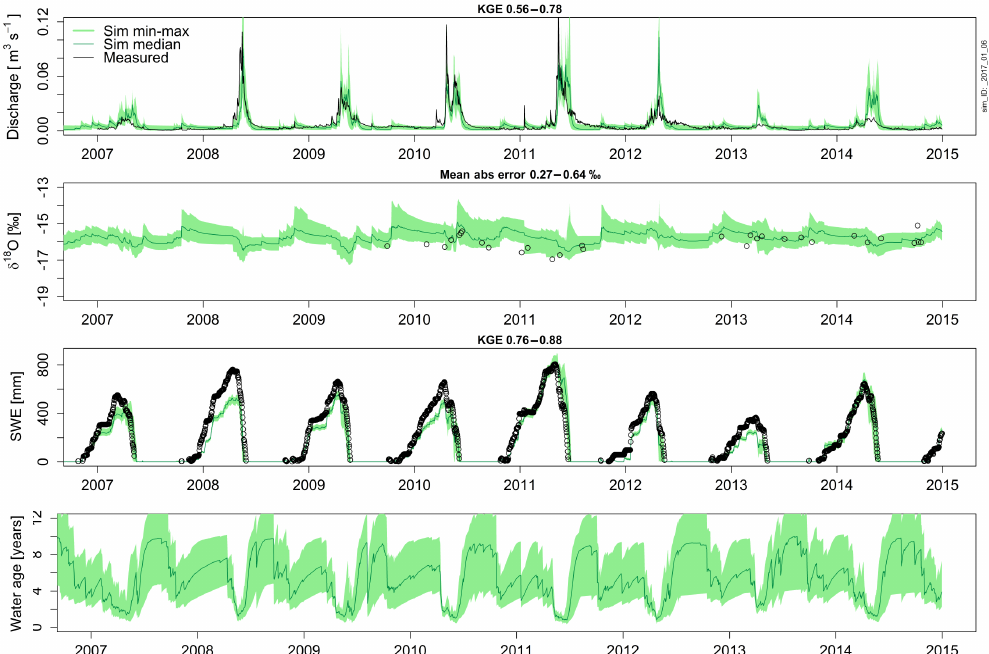
Figure 7. Bogus Creek simulation output: top panel shows the streamflow, second panel the isotope ratio at the stream outlet, third panel the SWE, and lowest panel the simulated stream water age. GOF measures are shown on plot titles.